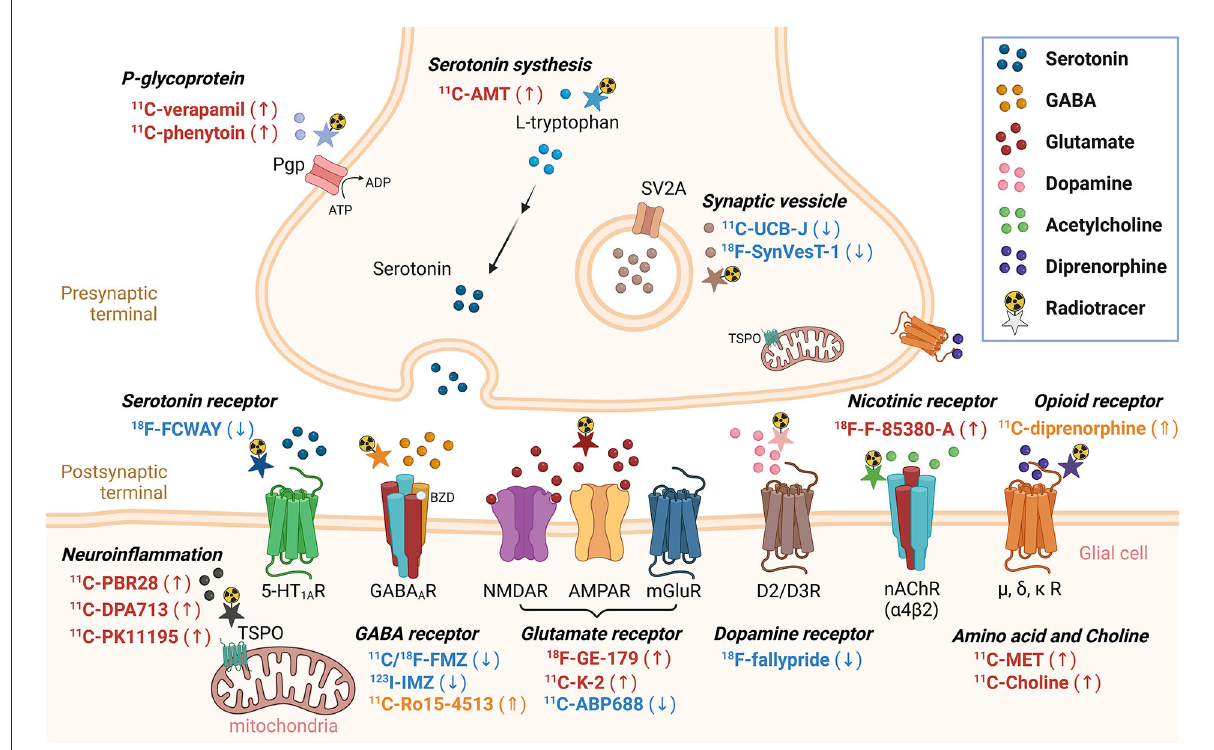
FIGURE2 Non-FDG radiotracers used in epilepsy in the last decade. Radiotracers with a downward arrow, upward arrow, or upward double arrow showed decreased uptake, increased uptake, or increased volume of distribution,